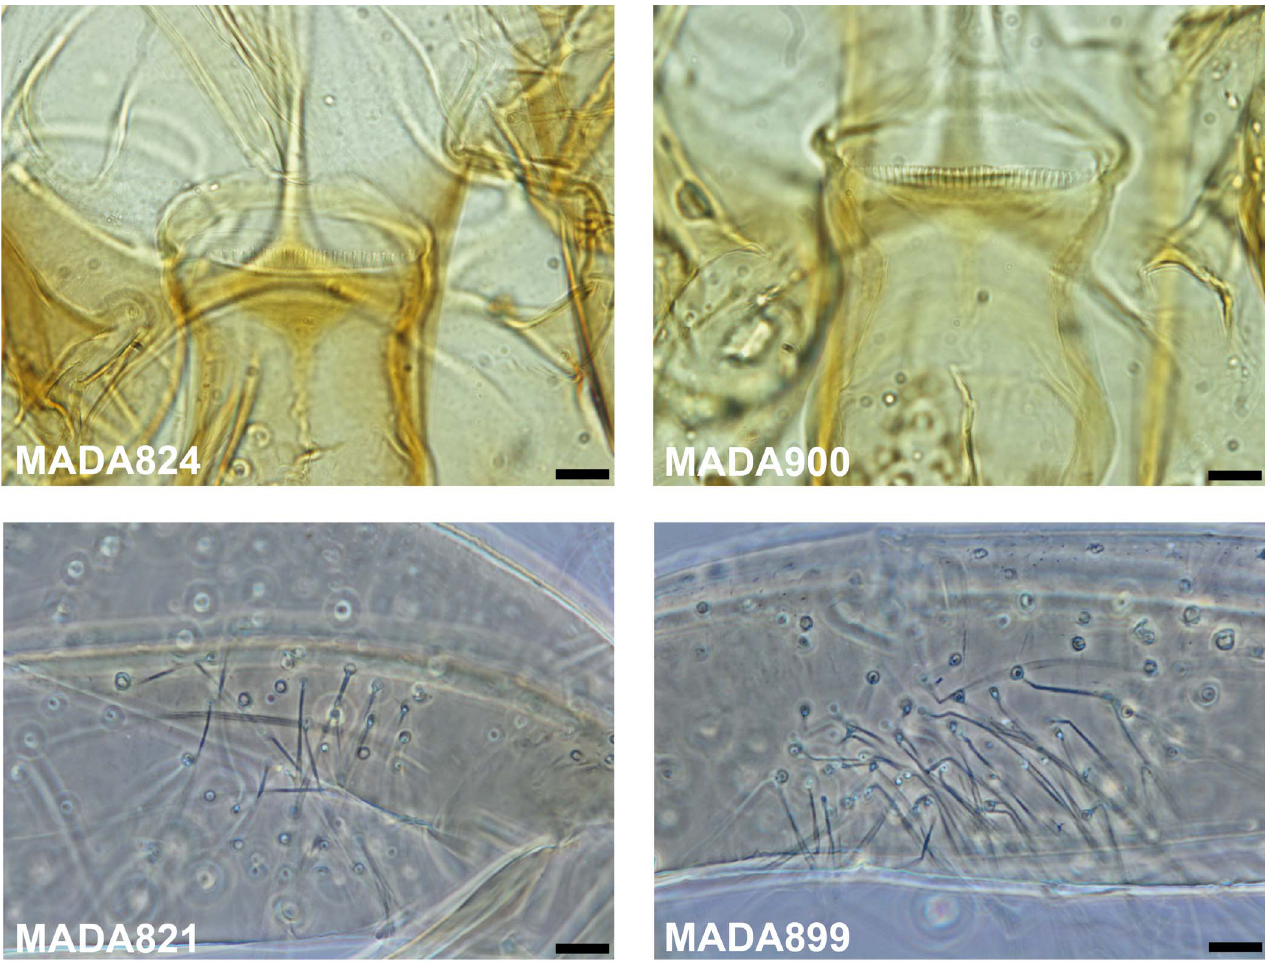
Figure 18. Sergentomyia (Ranavalonomyia) vol fi n. sp. Cibarial armatures of two females exhibiting 20 (MADA824) or 30 (MADA900) teeth and coxites of two males exhibiting 9 (MADA821) and 23 setae (MADA899). Bars = 10 l